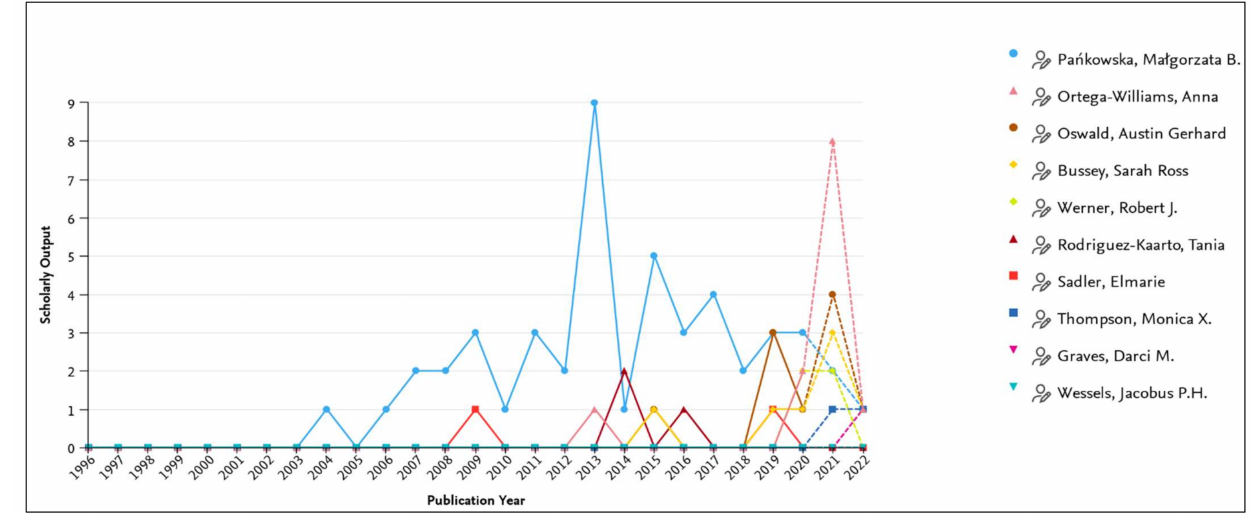
Figure 3. SciVal benchmarking comparison of Author’s publications with others.